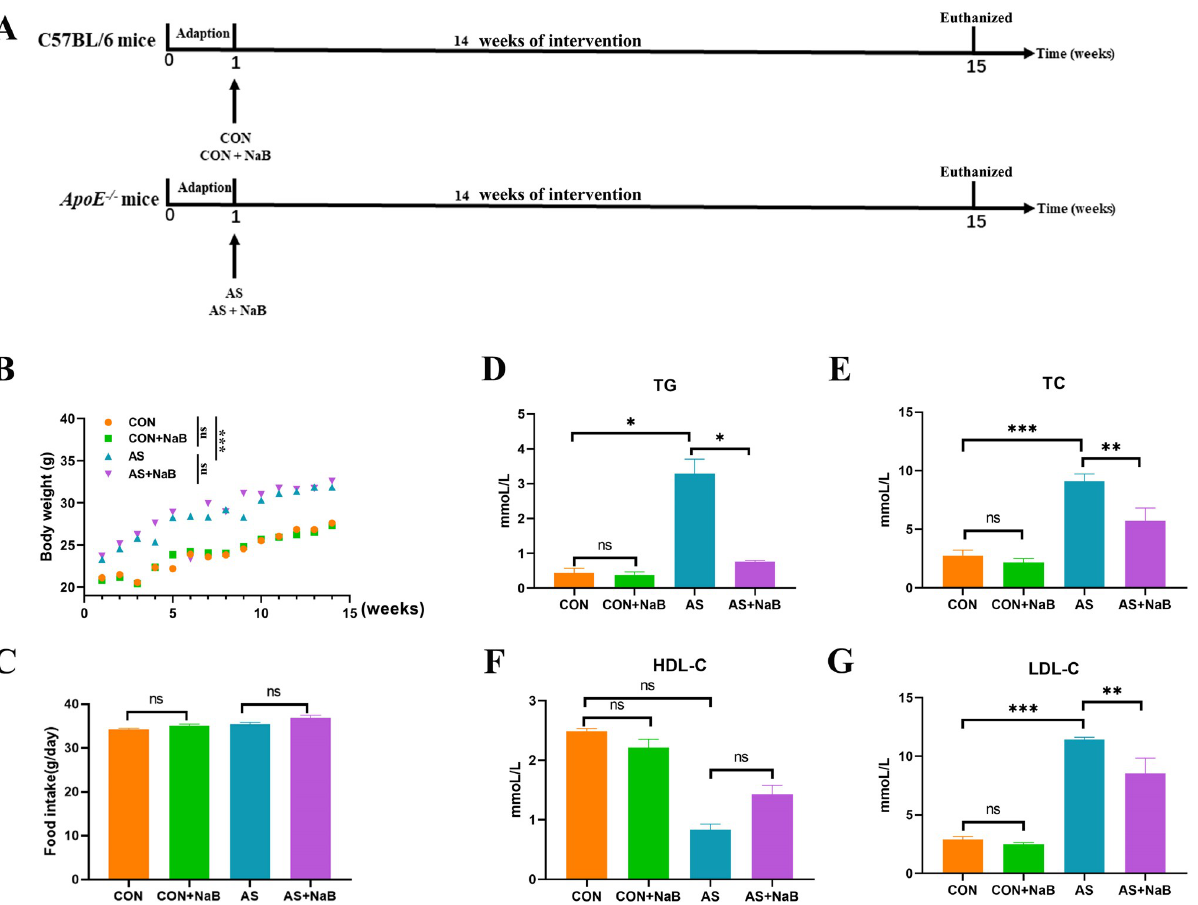
Fig 1. NaB alleviated physiological parameters and serum lipids in diverse groups. (A) Schematic time diagram of the experimental design. (B) Body weights (BWs) of 4 groups. (C) Food intake. (D) Triglyceride (TG). (E) Total cholesterol (TC). (F) High-density lipoprotein (HDL-C). (G) Low-density lipoprotein (LDL-C). Data were expressed as mean ± SEM. � P < 0.05, �� P < 0.01, ��� P < 0.001. ns, no significant difference. CON: control group; CON +NaB: sodium butyrate (NaB)-fed control group; AS: model group; AS+NaB: NaB-fed model